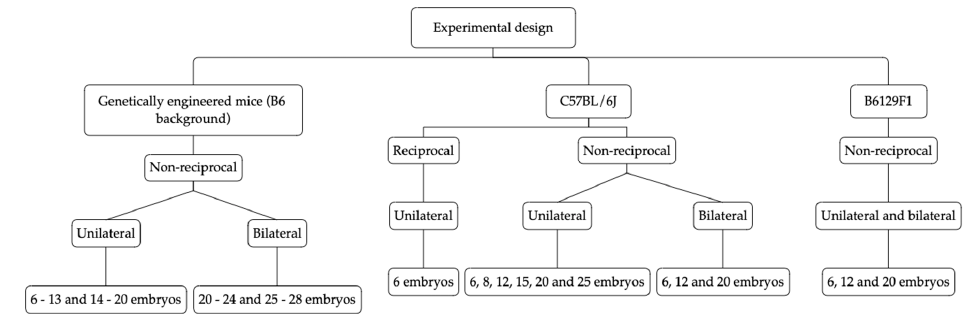
Figure 1. Experimental design and groups.